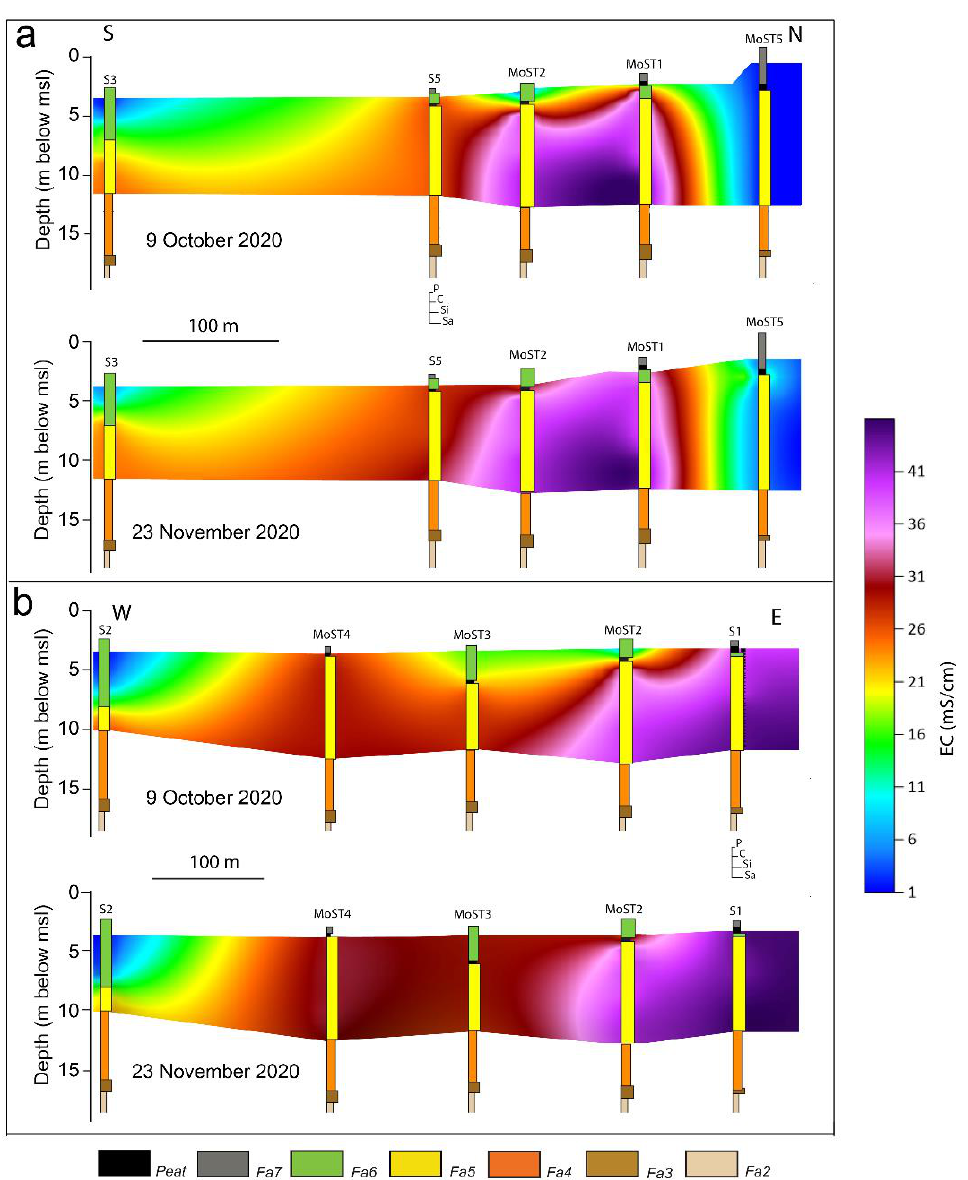
Figure 15. Interpolation of EC vertical profiles recorded on 9 October 2020 and 23 November 2020: ( a ) in N-S direction, ( b ) in W-E direction. The location of the stratigraphy of the studied cores and wells is reported in Figure 3 and Figure 14.